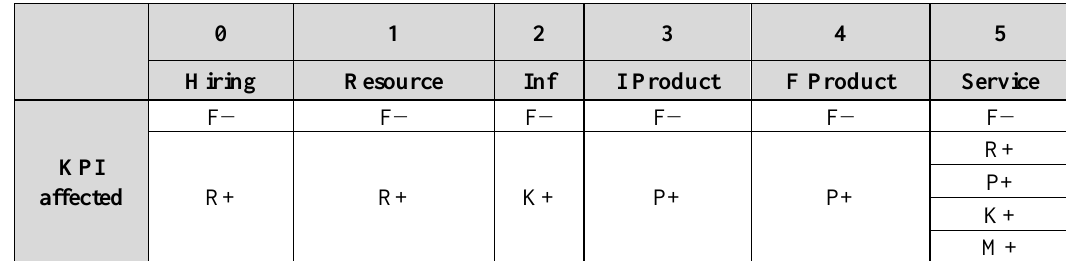
Table 4. The relation between KPI effect and exchange types